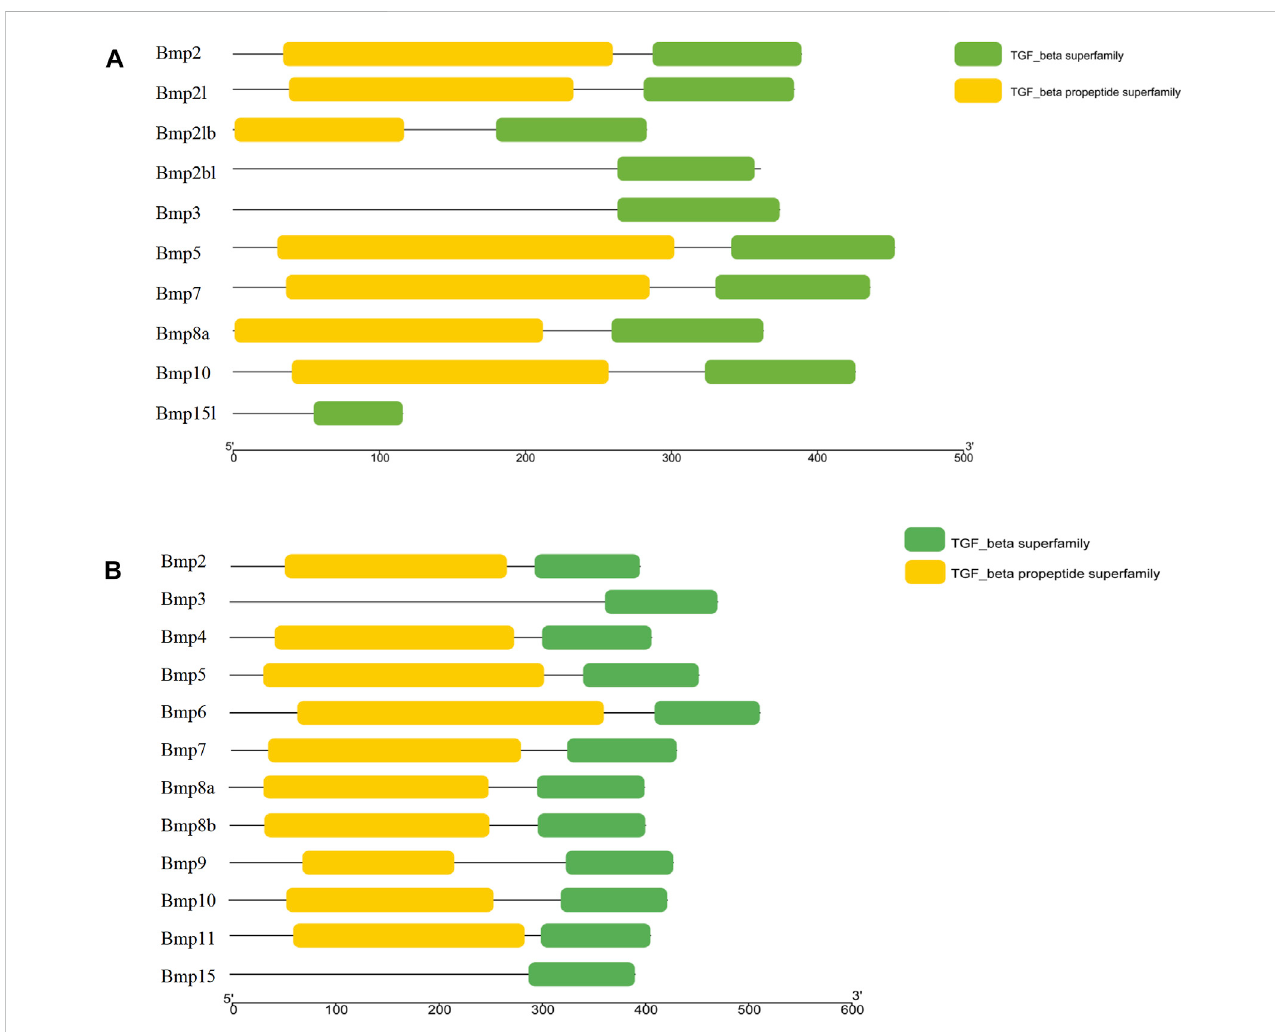
FIGURE 6 Conserved domains of BMP genes in P . sinensis (A) and Homo (B) . The green boxes and yellow boxes indicate the protein domains of the TGF- β superfamily and the TGF- β propeptide superfamily,